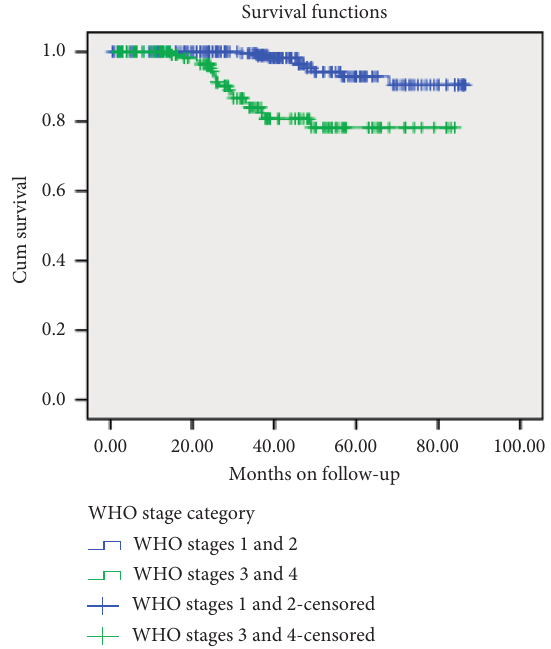
Figure 2: Survival curves for the cohort of children on ART according to their WHO clinical stage.